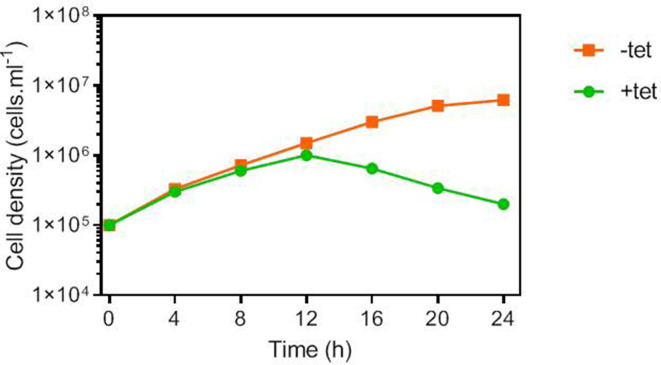
Growth Curve of CRK12 RNAi cells in full HMI-9 medium at 37°C/5% CO2, in the presence or absence of 1 μg/ml tetracycline (tet).Cell counts were performed with a haemocytometer and the average of duplicate determinations is shown. All data for these graphs are contained in Figure 5—source data 1.